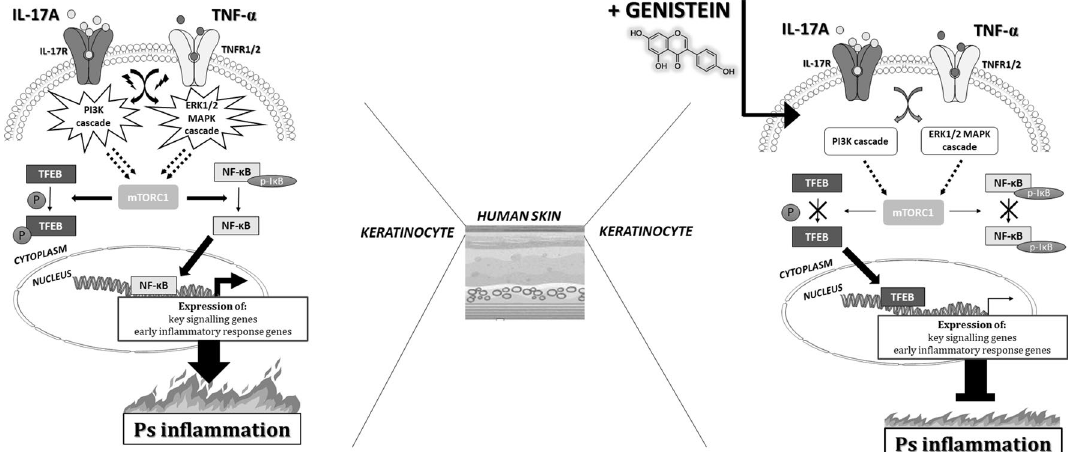
Figure 6. Schematic representation of the molecular basis of genistein action in control of psoriasis inflammation. IL-17A interleukin-17A, IL-17R interleukin-17 receptor, TNF-α tumor necrosis factor-alpha, TNFR1/2 TNF receptor-1/2, PI3K cascade phosphoinositide 3-kinase cascade, ERK1/2 MAPK cascade mitogen- activated protein kinase relevant extracellular signal-regulated kinase 1/2 cascade, TFEB transcription factor EB, P phosphorus, mTORC1 mammalian targets of rapamycin complex 1, NF-κB nuclear factor kappa-light-chain- enhancer of activated B cells, p-IκB phosphorylase inhibitor of kappa B, Ps inflammation psoriasis inflammation. Figure created using the receptors, human skin and flame graphs designed by brgfx/Freepik (www. freep ik. com) and Servier Medical ART/SMART (https:// smart. servi er.